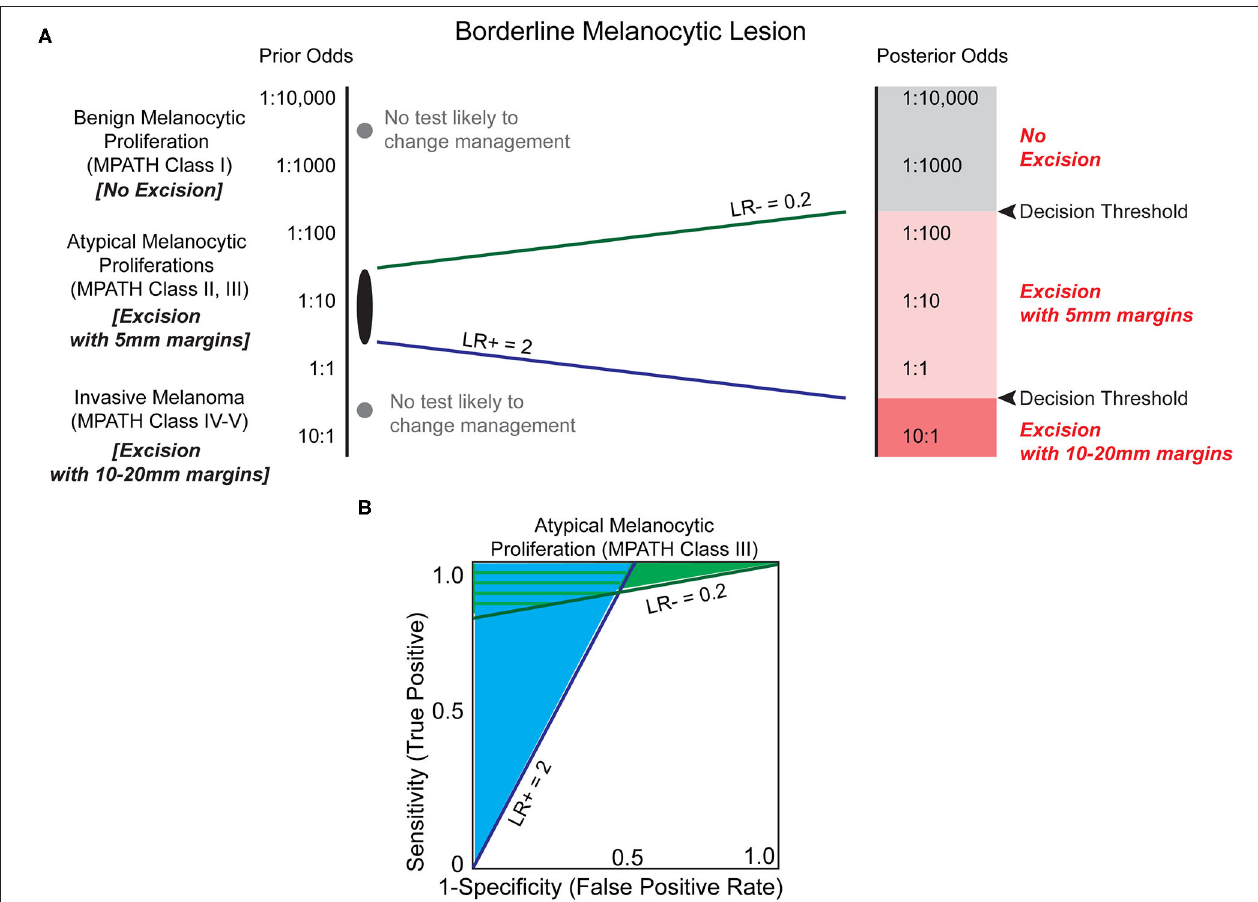
FIGURE 4 | Biomarkers have the potential to clarify the risk of melanoma in the histopathologic interpretation of borderline pigmented lesions. (A) Melanocytic lesions exist on a histologic spectrum from benign-appearing to malignant. At the extremes of this spectrum (e.g., unambiguous benign melanocytic nevus (MPATH-Dx class I) or unambiguous invasive melanoma (MPATH-Dx class IV-V) no biomarker test is likely to change management (gray dots, Table 1 ). For borderline melanocytic lesions, especially MPATH-Dx class II-III lesions, pathologists are generally conservative and recommend excision of ambiguous lesions that may have no